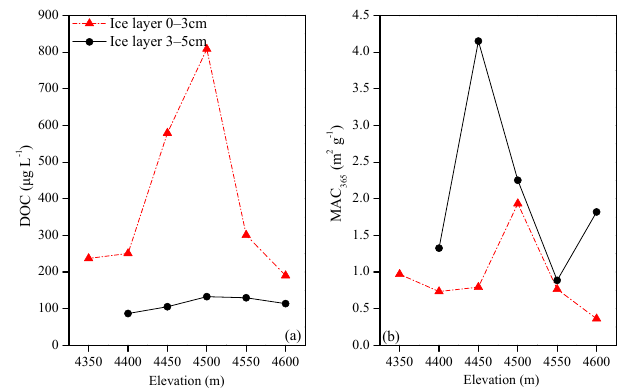
Figure 6. Comparison of DOC concentrations (a) and MAC 365 (b) between surface and subsurface ice.